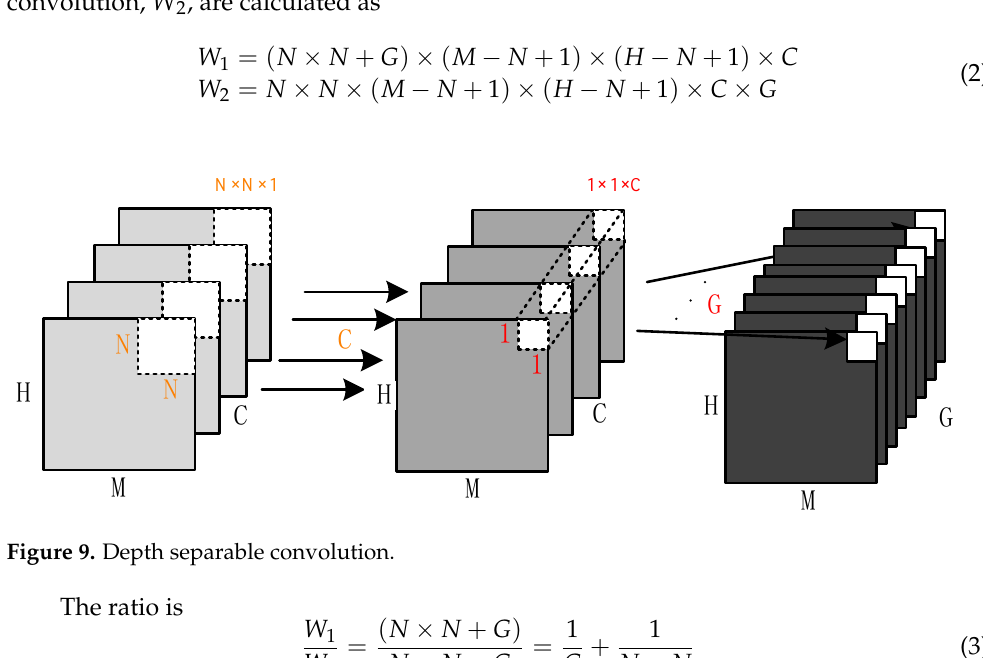
Figure 9. Depth separable convolution.